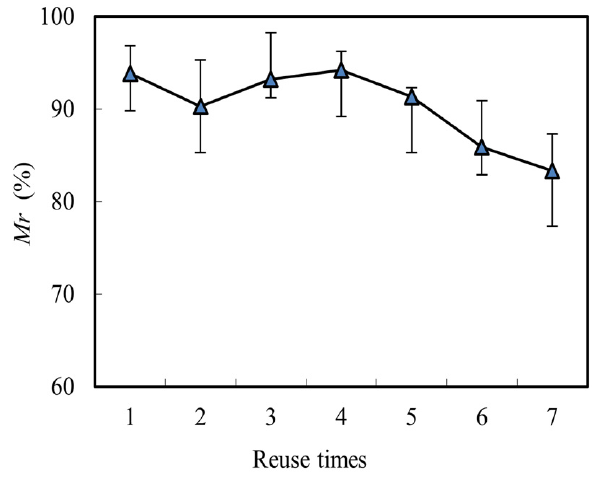
Figure 7. The effects of reuse time on the migration rate ( Mr ) of Mo(VI).